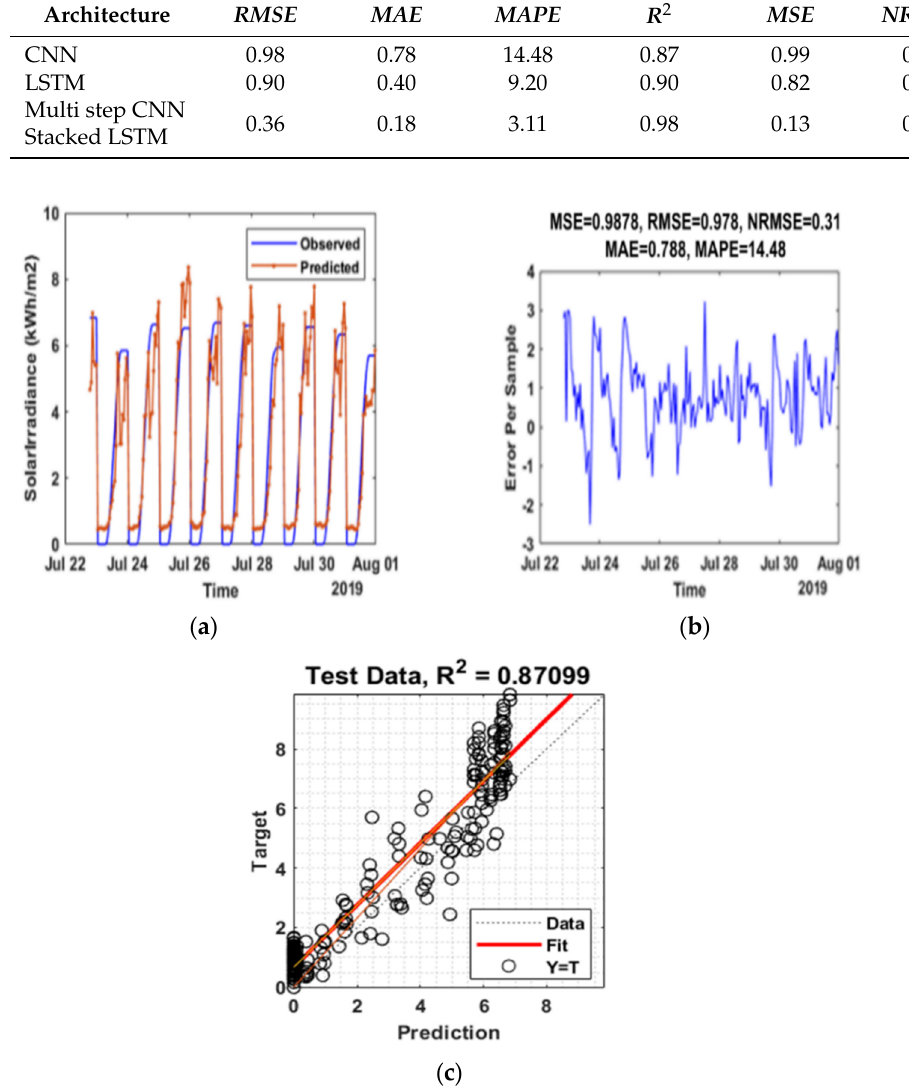
Figure 6. ( a )The observed and predicted results, ( b ) error metrics and ( c )regression plot considering Figure 6. ( a ) The observed and predicted results, ( b ) error metrics and ( c ) regression plot considering solar irradiance-Sweihan photovoltaic independent power project, Abu Dhabi-for CNN. solar irradiance-Sweihan photovoltaic independent power project, Abu Dhabi-for